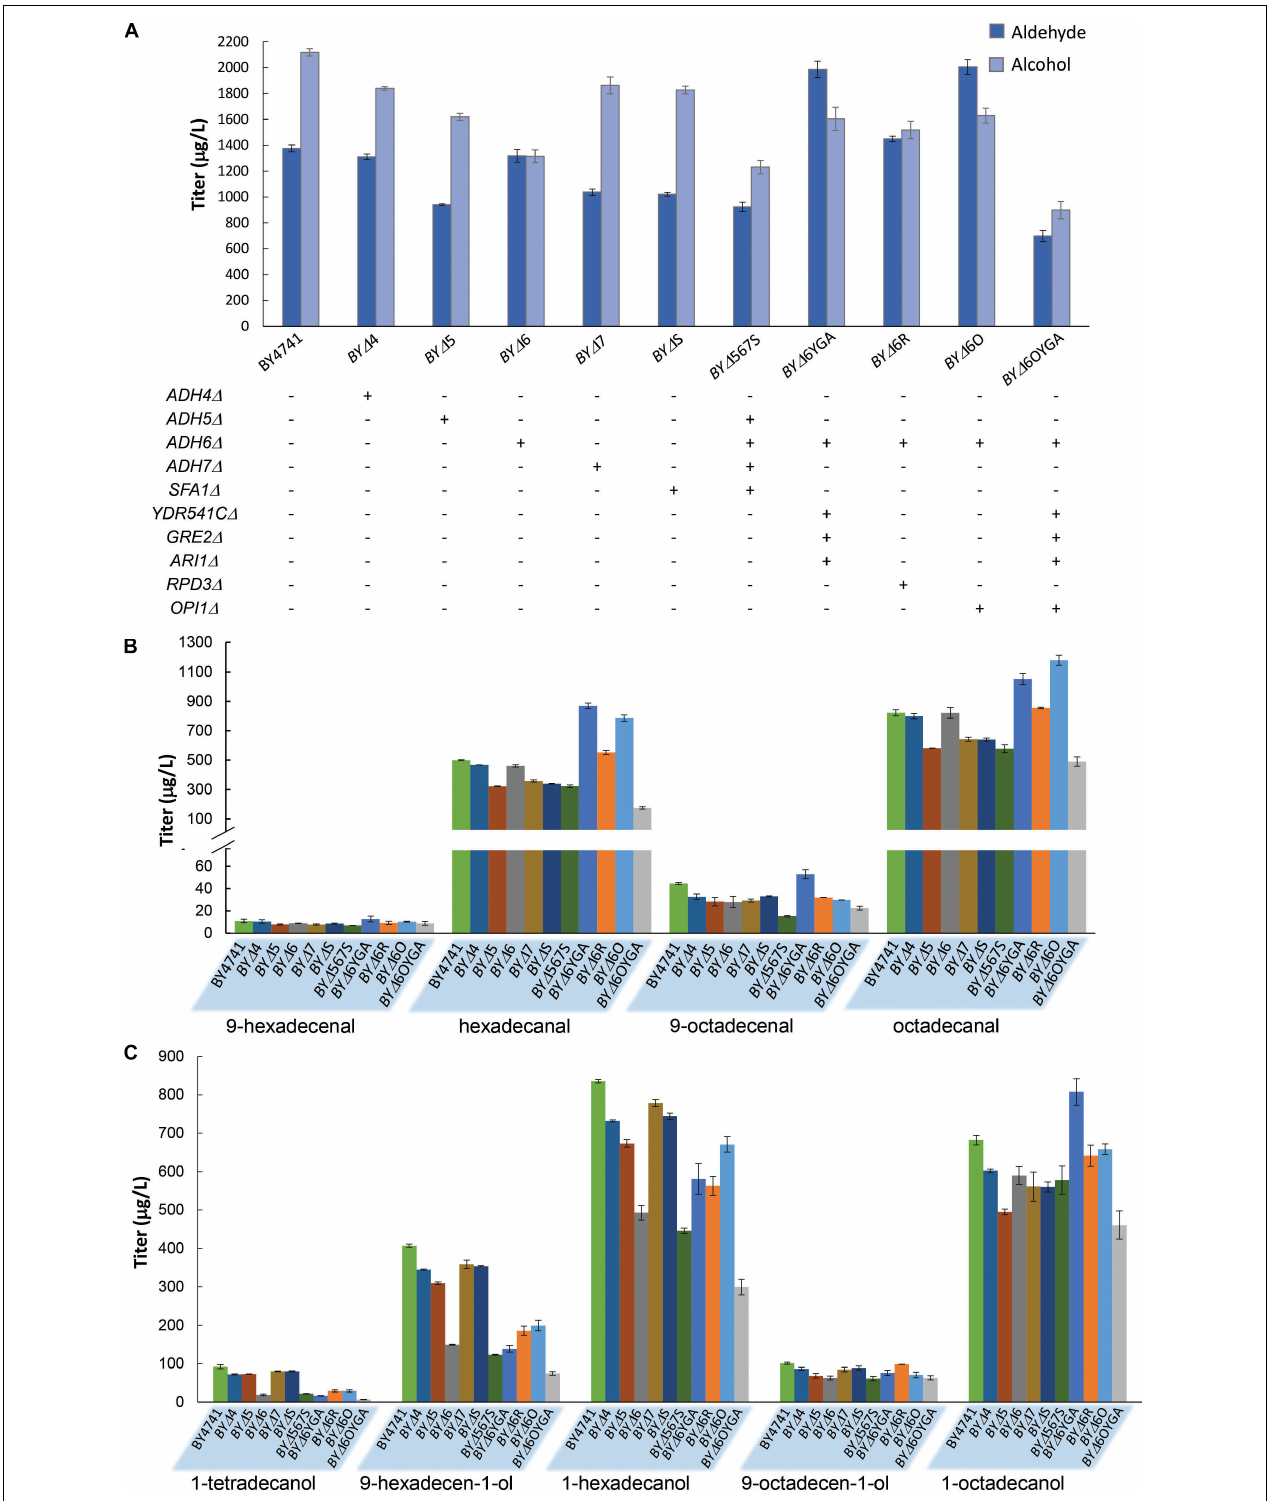
FIGURE 4 | Fatty aldehyde and alcohol production from Saccharomyces cerevisiae mutants expressing maFACR SYK . (A) maFACR was expressed in S. cerevisiae mutants with various gene inactivation and the total fatty aldehyde and alcohol titers are shown. “+” and “-” denote the presence and absence of the indicated gene inactivation in the corresponding strain. (B,C) Show the compositions of fatty aldehydes and alcohols, respectively, in the various yeast mutants. Data are shown as the mean ± SD of biological duplicates.